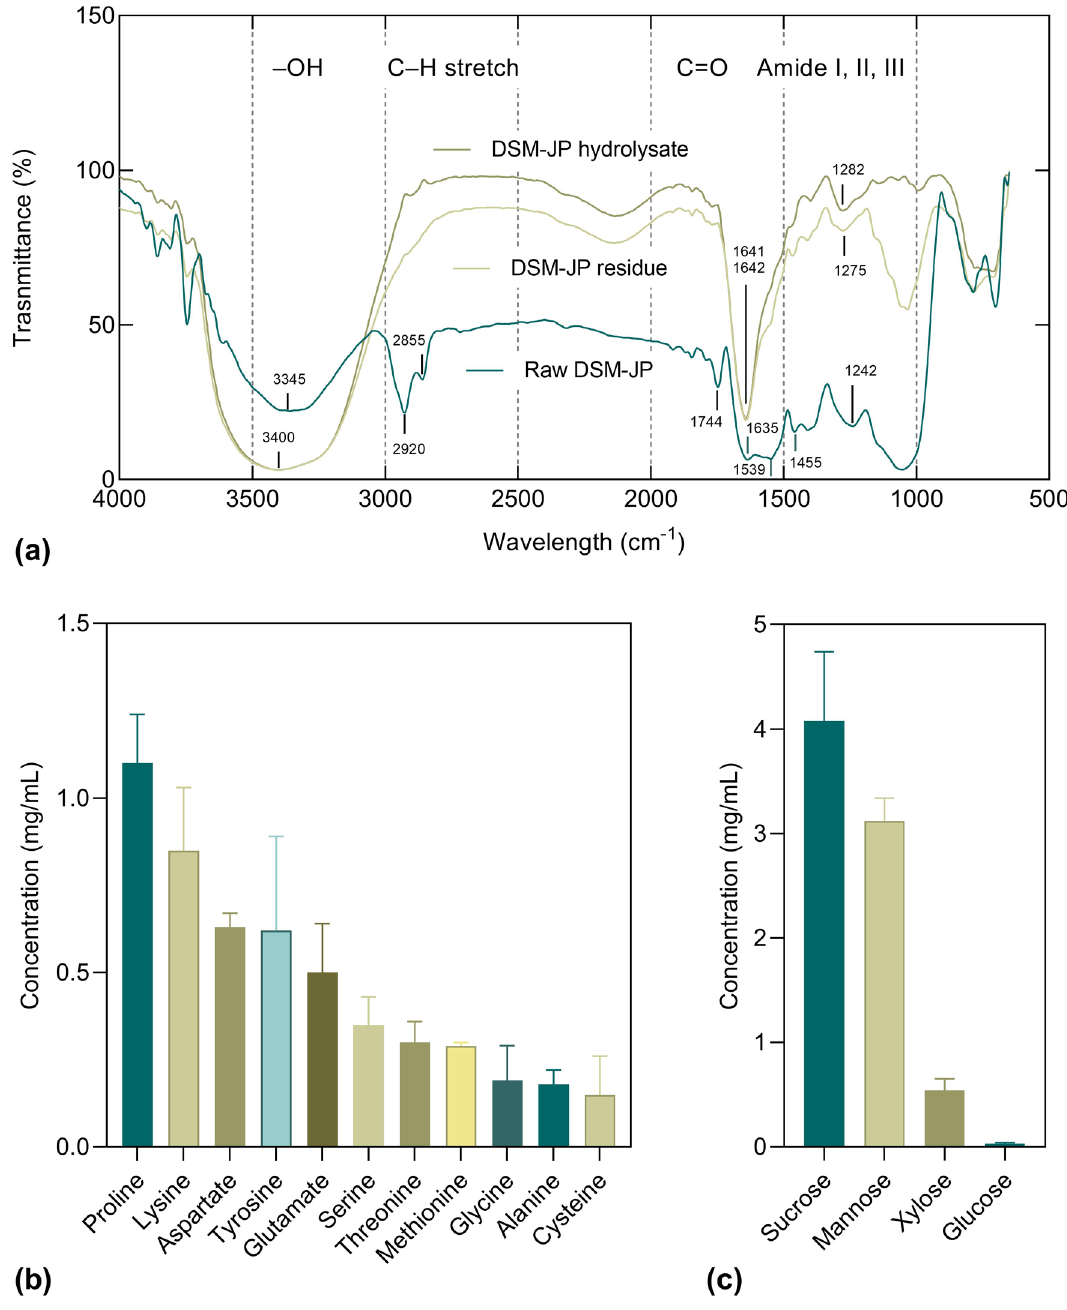
Figure 3. Changes in the chemical structure of hydrolyzed DSM-JP: ( a ) FTIR spectra of raw, residue, and hydrolysate of DSM-JP; ( b ) amino acid and ( c ) sugar profiles of DSM-JP hydrolysate. Mean data of triplicate experiments were presented with error bars represent standard deviations. The graphs were visualized in GraphPad PRISM software (v 8.02; GraphPad, Inc., MN, USA; www. graph pad.